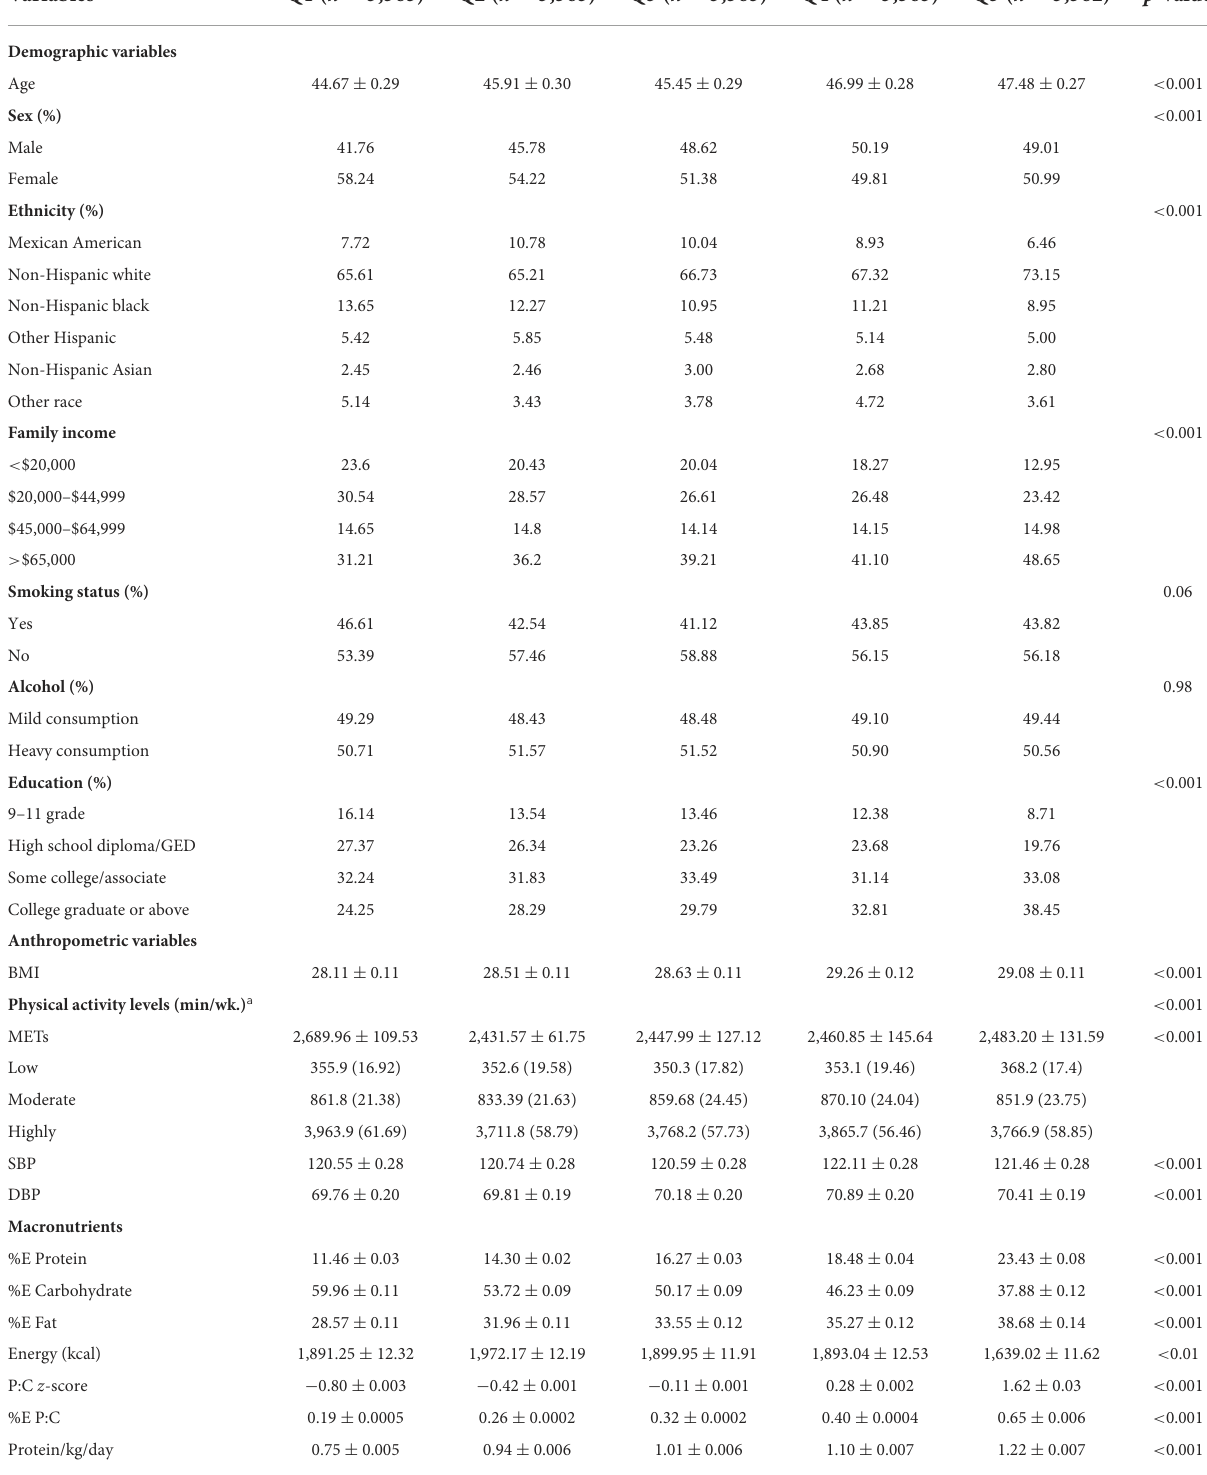
TABLE 1 Baseline characteristics of the study population by %E P:C z -score